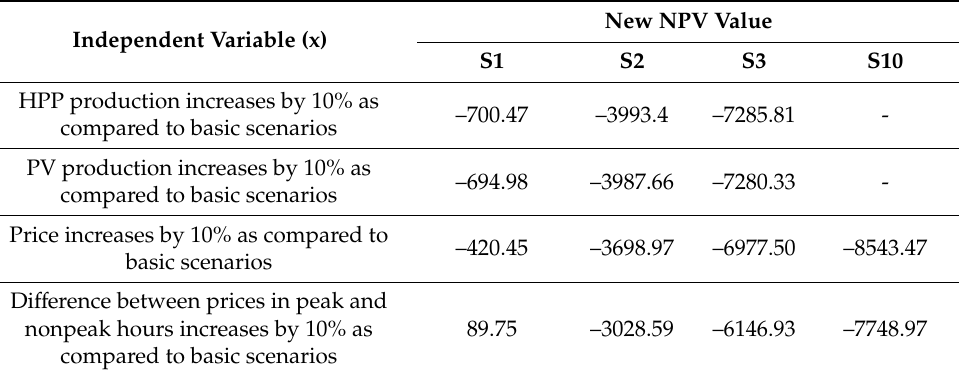
Table 4. NPV output value (tPLN).